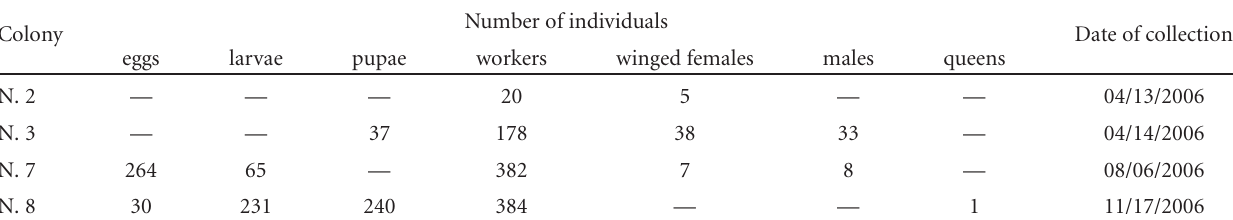
Table 1: Composition of the colonies of Pachycondyla striata